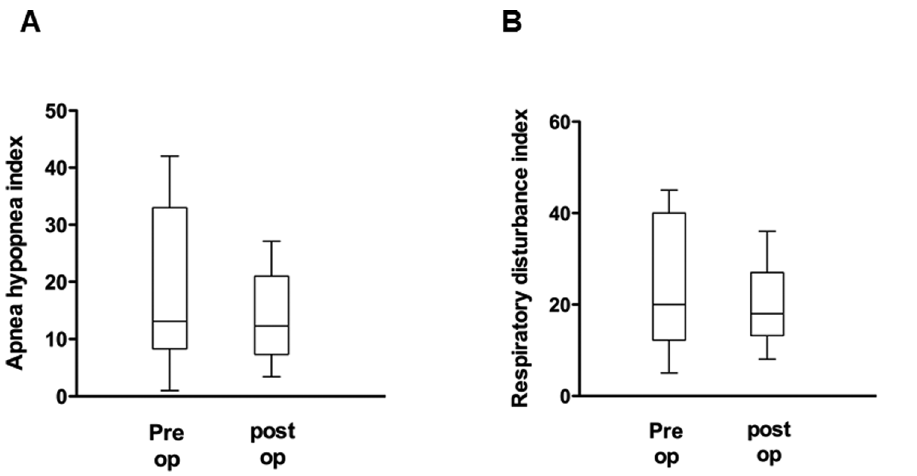
Figure 6. Changes in watch-PAT-derived factors, such as AHI (A) and RDI (B), before and after nasal surgery in the non-responder group